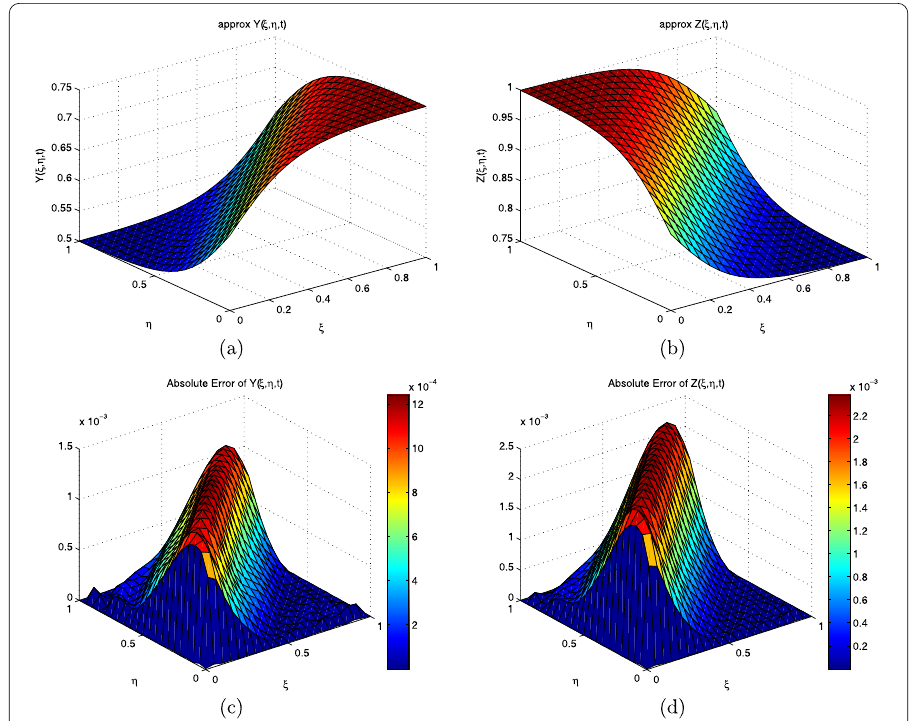
Figure 5 Solution profile and error analysis of Example 7 for T = 0.01, N = 400, Re = 50, and dt =